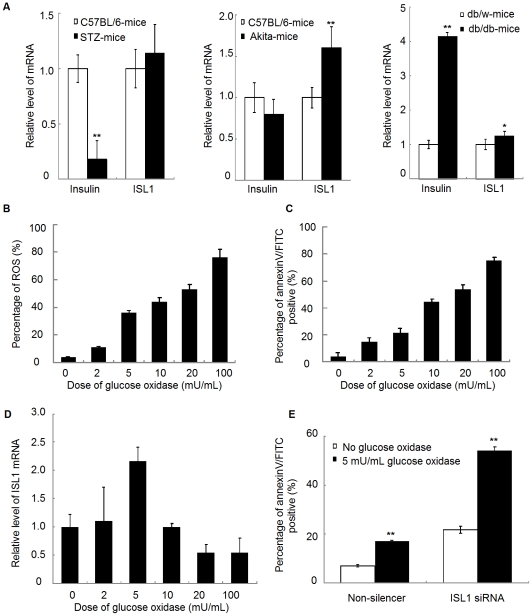
ISL1 was highly expressed in adult pancreatic islets and could reduce apoptosis in HIT-T15 cells.(A) Relative mRNA expression level of insulin in pancreatic islets from STZ mice (n = 6), Akita mice (n = 5) and db/db mice (n = 6) were measured by real-time RT-PCR. C57BL/6 mice (n = 6) were used as controls to STZ mice and Akita mice, db/w mice (n = 6) were as controls to db/db mice. Each bar represents mean ± SD (**p<0.01, *p<0.05, vs. the controls). (B) Level of ROS production was measured by flow cytometry analysis in HIT-T15 cells treated with glucose oxidase (GO) at various concentrations (0–100 mU/mL) for 4 h. (C) Level of apoptosis rate was measured by flow cytometry analysis in HIT-T15 treated with GO at various concentrations (0–100 mU/mL) for 4 h. (D) Relative level of ISL1 mRNA expression in HIT-T15 cells treated with different GO concentrations was examined by real-time RT-PCR. (E) Level of apoptosis rate was measured by flow cytometry analysis in stable ISL1 knockdown HIT-T15 cells treated with or without 5 mU/mL GO. Each bar represents mean ± SD from three samples (**p<0.01, vs. the control).